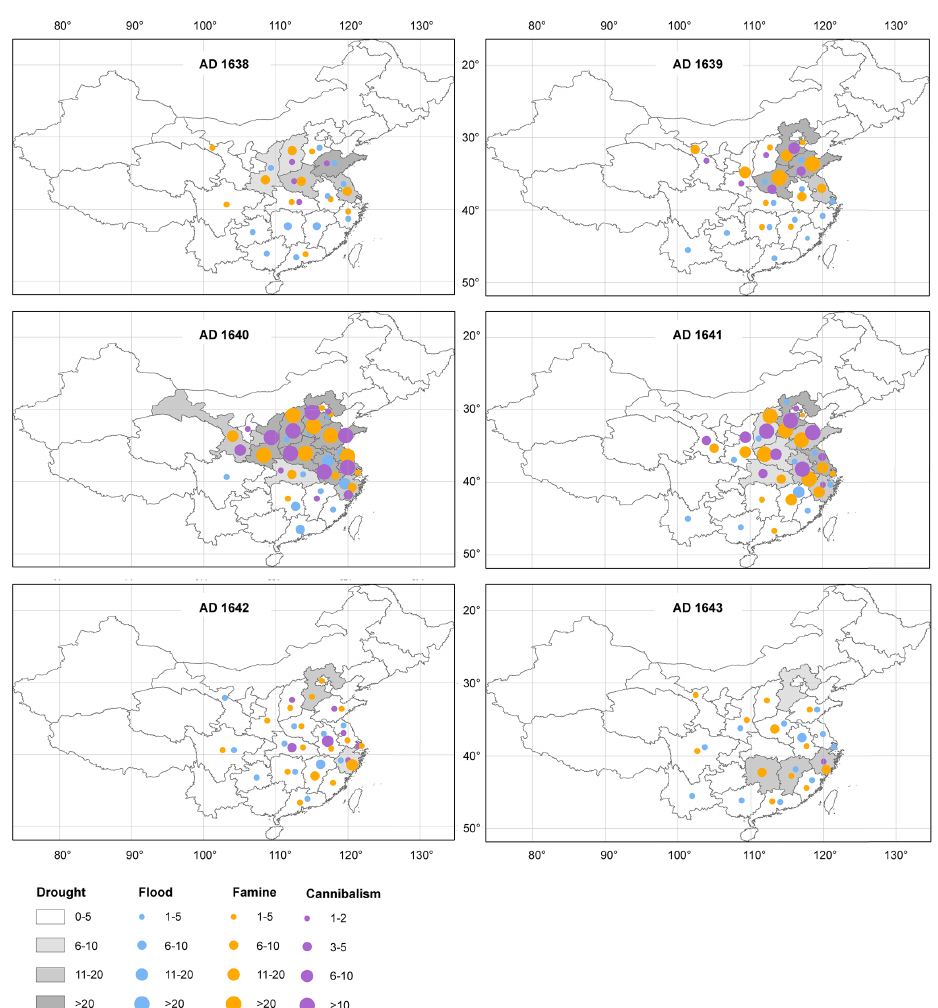
Figure 9. Weather anomalies and social disasters, 1638 to 1643, in China (Gao et al., 2017). Background shading indicates recorded drought event numbers each year per province (the darker the shade, the more severe the drought damage). Blue circles represent abnormal flood event frequencies each year per province (larger circles equal higher frequencies). Pink and red circles present the number of recorded famine and cannibalism events,